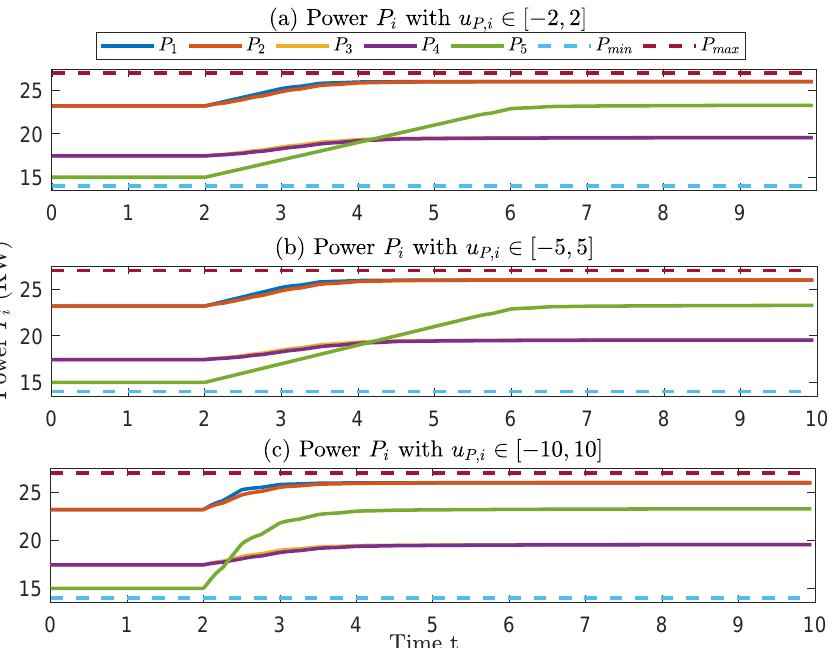
Figure 5. The power P i under the different states of control input: ( a ) u P , i ∈ [ − 2,2 ] ; ( b ) u P , i ∈ [ − 5,5 ] ; ( c ) u P , i ∈ [ − 10,10 ] .